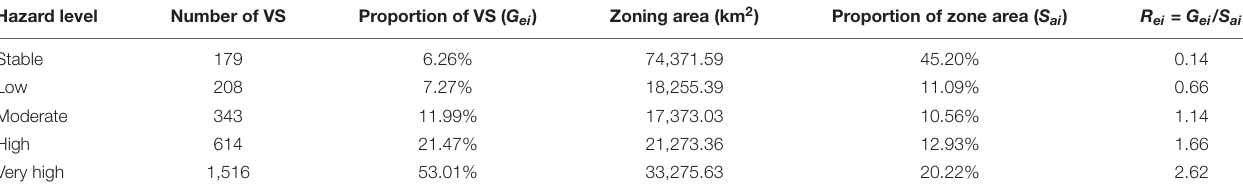
TABLE 6 | Distribution of the VS landslides in different hazard zones derived from Model 1 ( Table 4 ).